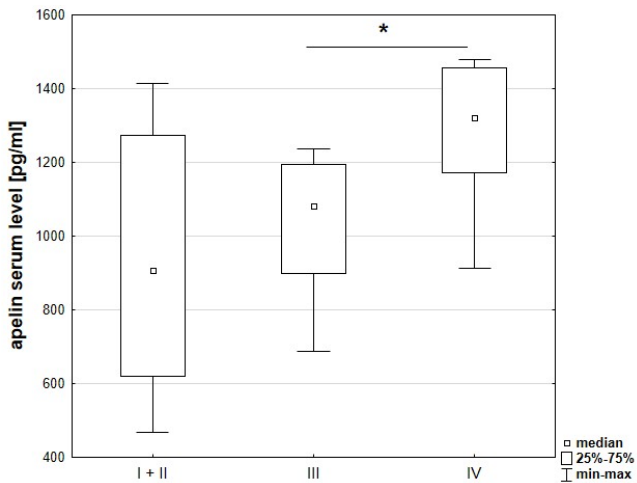
Figure 2. Apelin serum levels in patients with different stages of CRC. These data were analysed using the post-hoc Dunn’s test. * Statistically significant at p < 0.05.